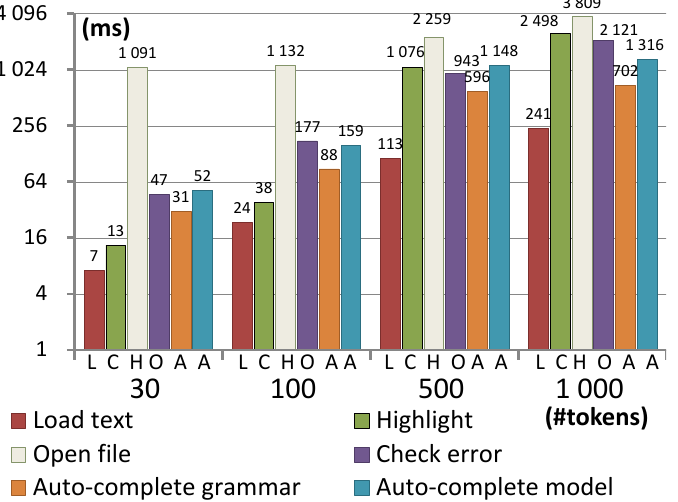
Figure 8. Worst-case features performance for varying Petri nets model